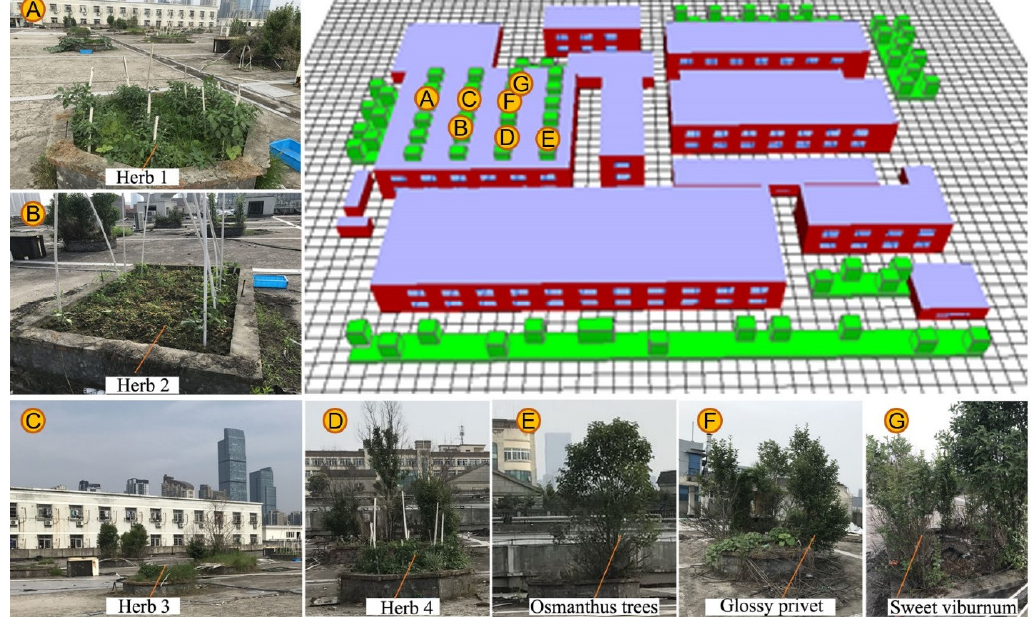
Figure 6. Photos of rooftop vegetation and the initial ENVI‐met model.